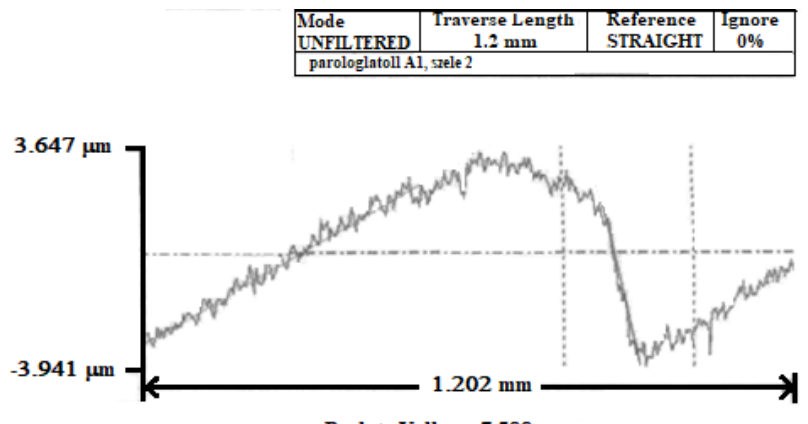
Figure 6. Measured radius on Talysurf 120L.